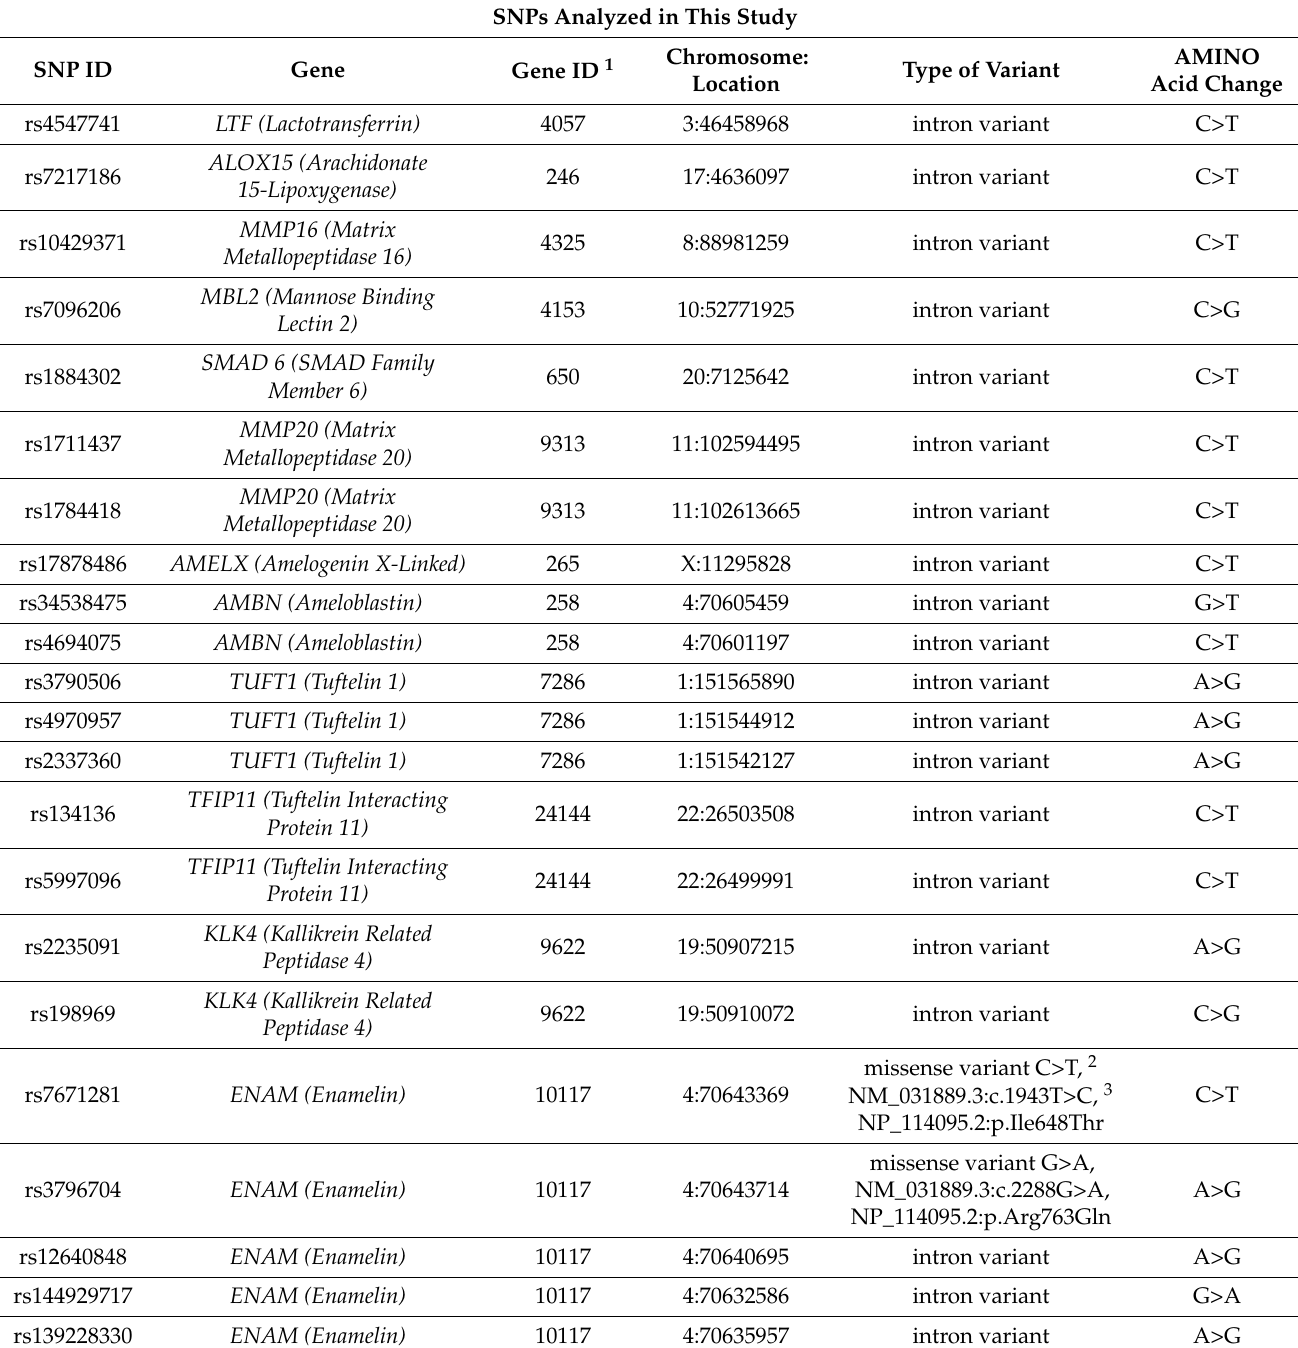
Table 1. Twenty-two differentiated SNPs analyzed in the current